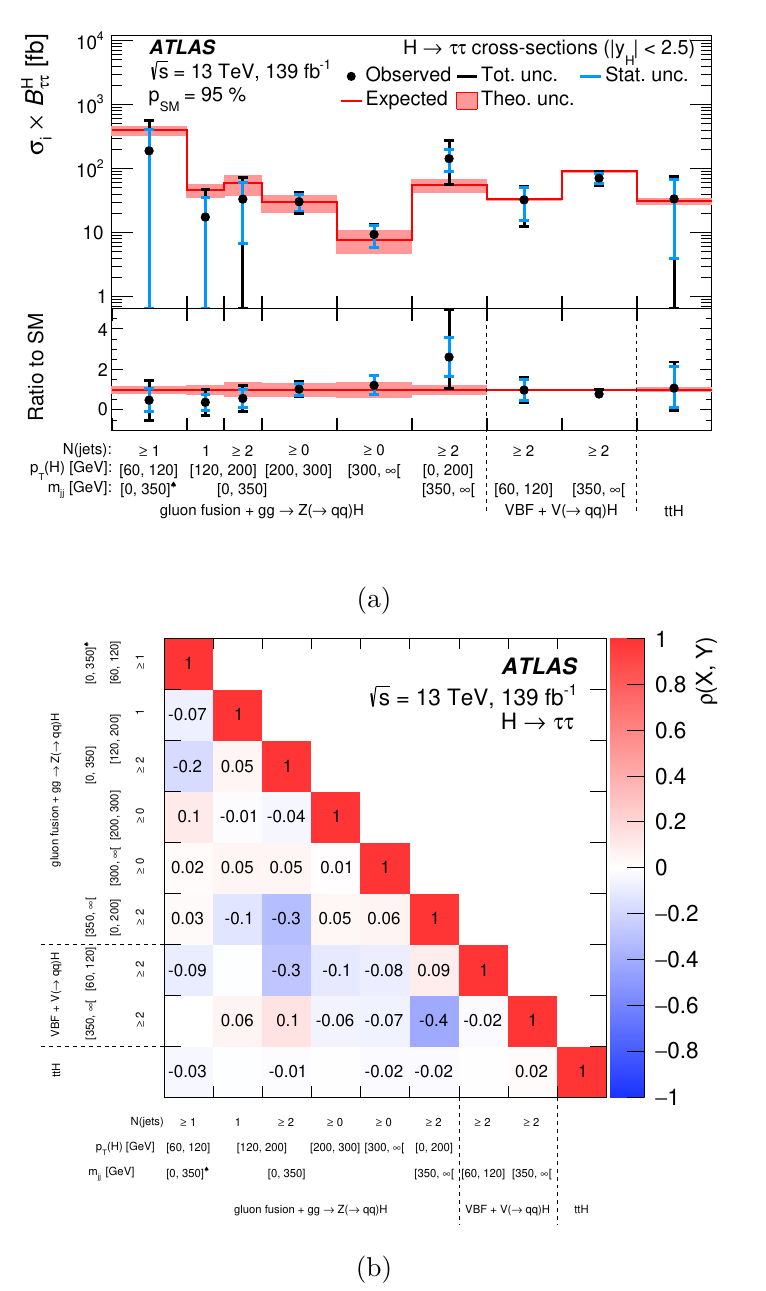
Figure 14. (a) The measured values for σ × B ( H → ττ ) relative to the SM expectations in the H nine fiducial volumes defined in the STXS measurement. Also shown is the result from the combined fit. The total ± 1 σ uncertainty in the measurement is indicated by the black error bars, with the individual contribution from the statistical uncertainty in blue. (b) The measured correlations between each pair of parameters of interest in the STXS measurement. The spades symbol ( ♠ ) indicates that the criteria for m only apply to events with at least two reconstructed jets. The jj measured values for σ × B ( H → ττ ) along with the corresponding correlation matrix are available H in the HEPData repository